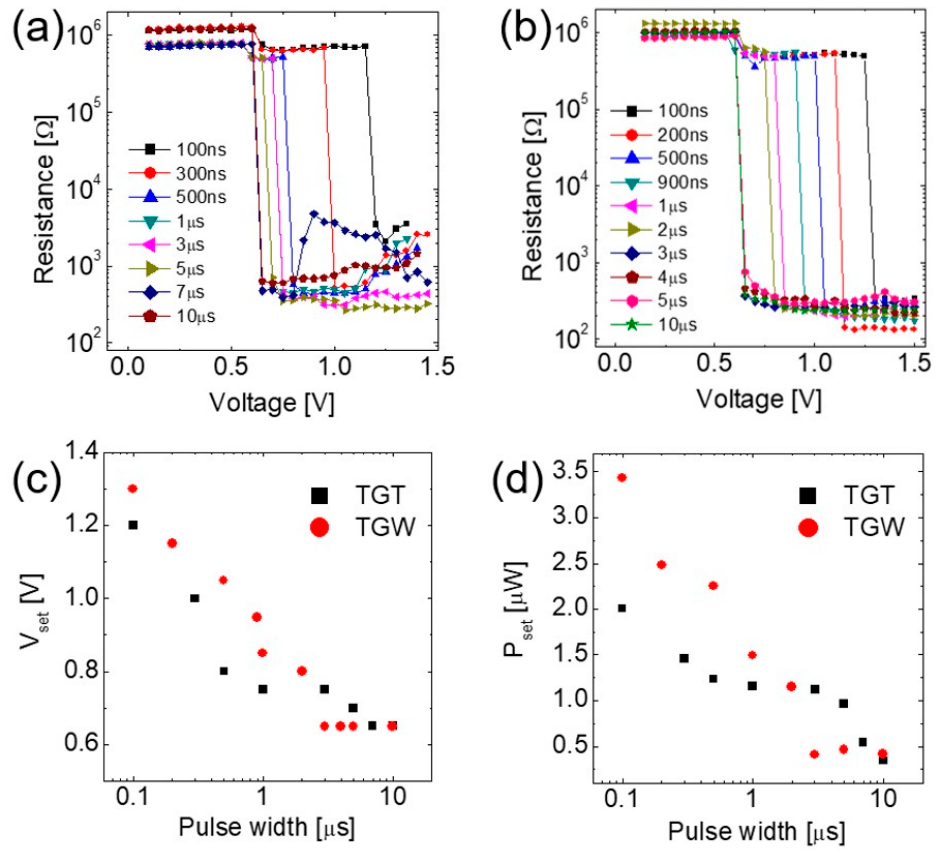
Figure 3. R–V curves obtained by changing the pulse width: ( a ) TGT and ( b ) TGW devices. Variation in ( c ) V set and ( d ) P set as a function of pulse width for TGT and TGW devices.